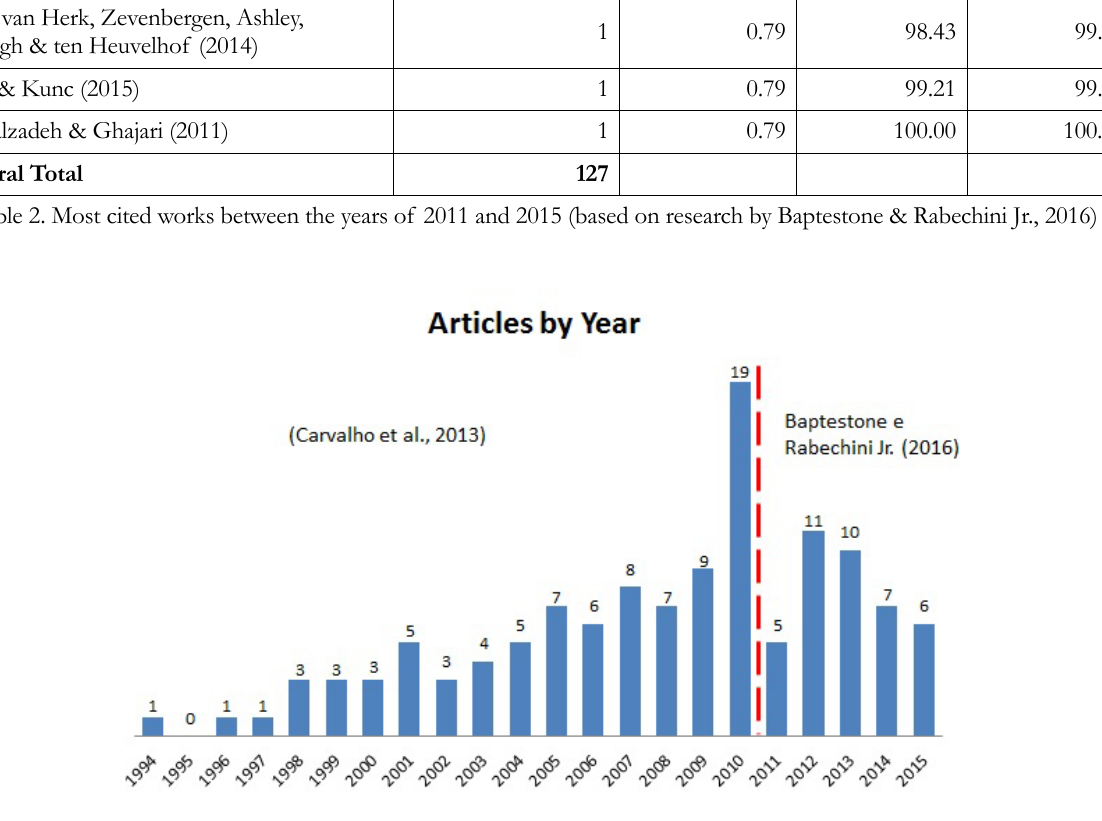
Figure 3. Articles with the key “Portfolio Management” and “Project Management” between 1994 and